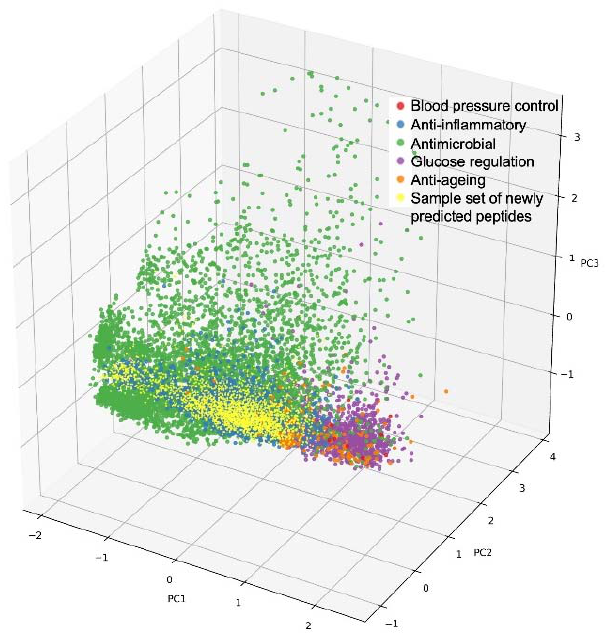
Figure 1. Illustration of a multi-dimensional peptide property space: 3D projection of annotated bioactive peptides according to three principal components (PC1-3), visualized as colored dots according to different health benefits. Red: blood pressure control; blue: anti-inflammatory; green: anti ‐ microbial; magenta: glucose regulation; orange: anti ‐ ageing; yellow: sample set of newly predicted peptides.